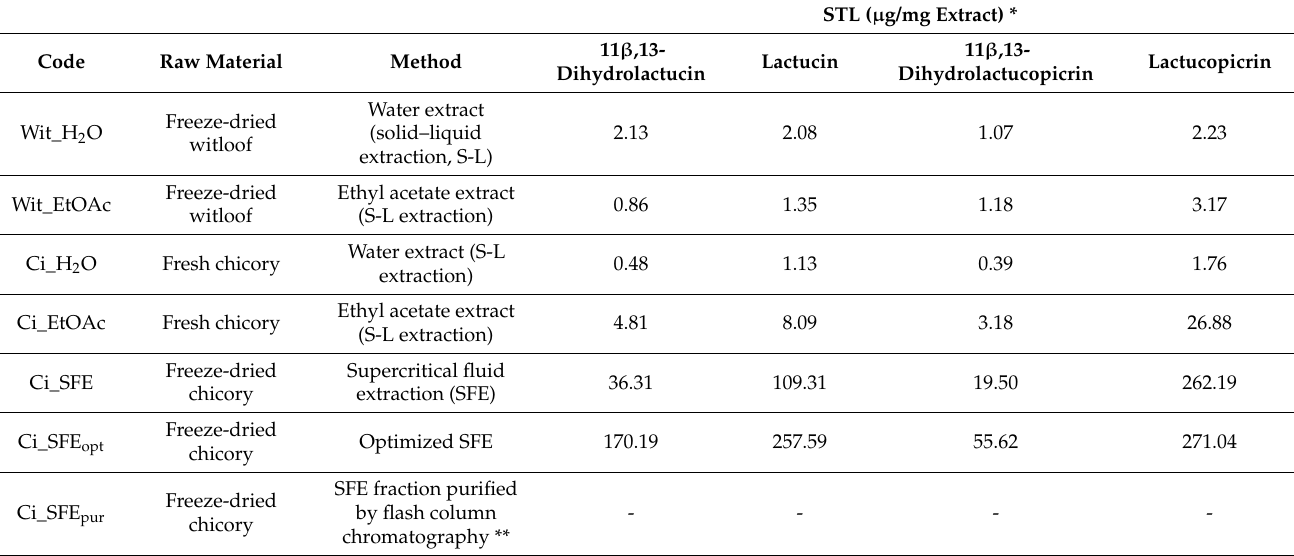
Table 1. Industrial chicory and witloof extracts used in the bioactivity